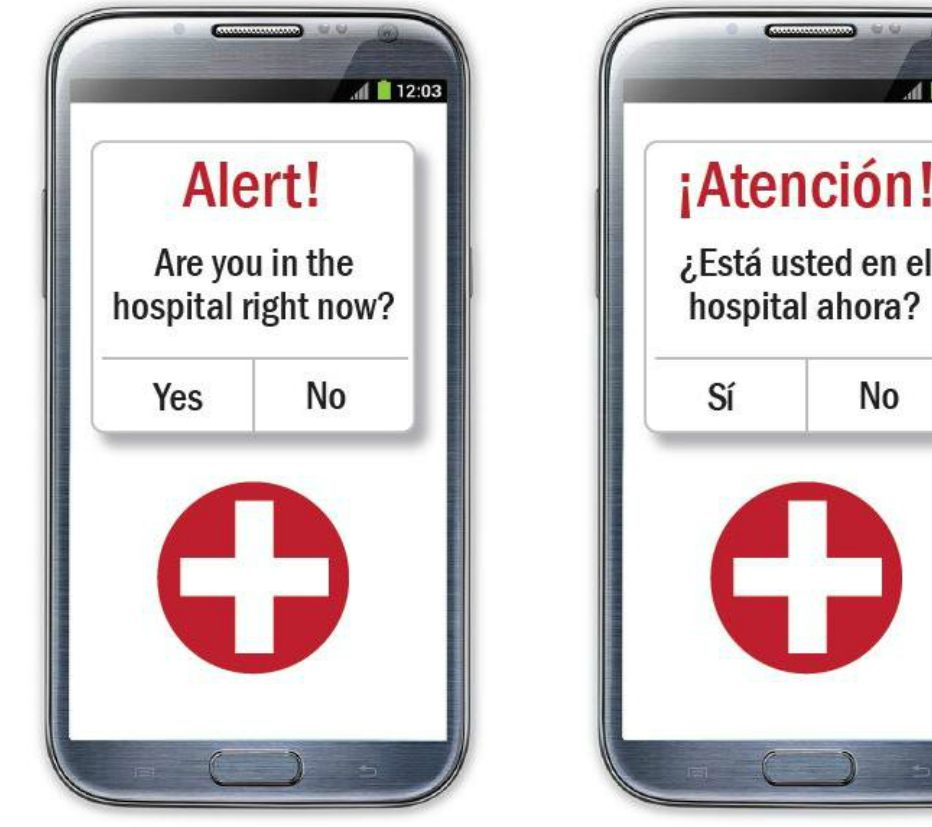
Figure 1. Proposed push notification sent to patient’s smartphone after app detects a potential hospital visit (left: English; right: